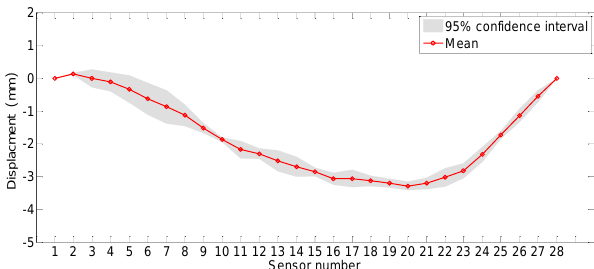
Figure 16. Deformation profile for the instrumented segment.